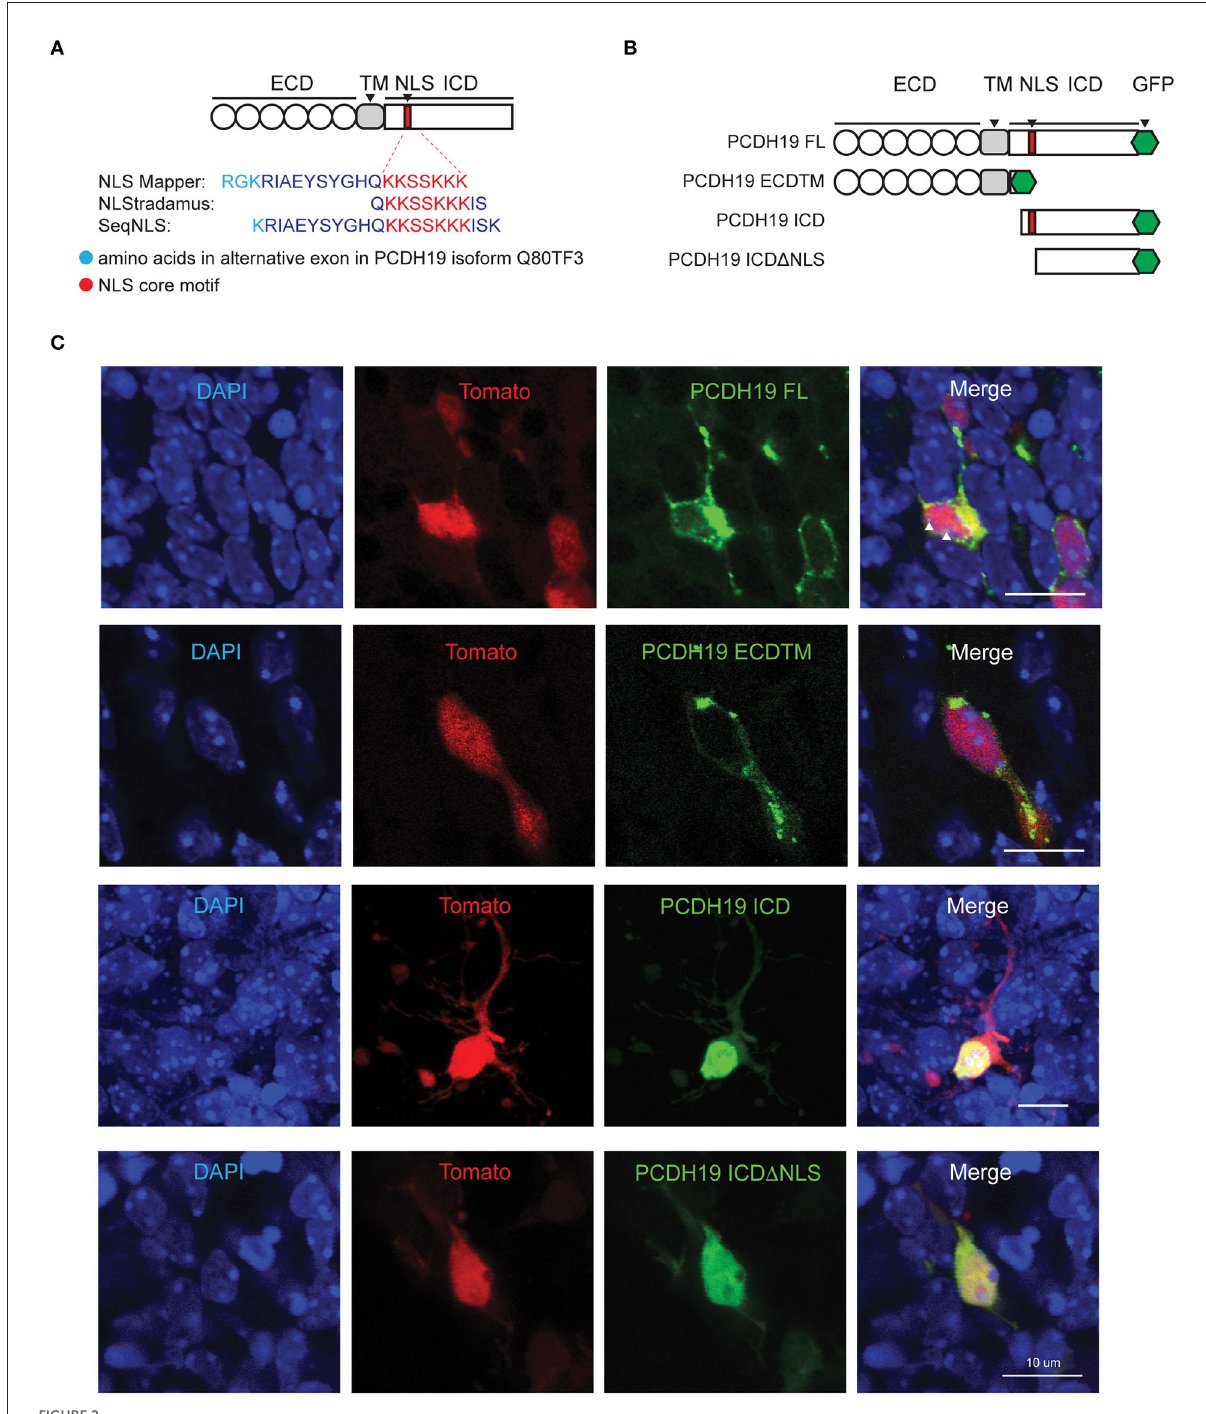
FIGURE2 PCDH19 subdomain constructs target expression to different subcellular locations. (A) NLS prediction within the mouse PCDH19 amino acid sequence with three different programs. Cyan represents the alternate exon and red the consensus sequence. (B) Full-length PCDH19 and overexpression subdomain constructs were produced C-terminally tagged with a GFP tag and inserted into a bicistronic plasmid containing TdTomato. (C) PCDH19 subdomain expression in slice EP neurons 72h after electroporation. Separate fluorescence channels, as well as the overlay, show a similar subcellular localization to the Neuro2A cells. White arrowheads in PCDH19 FL indicate a GFP signal in the